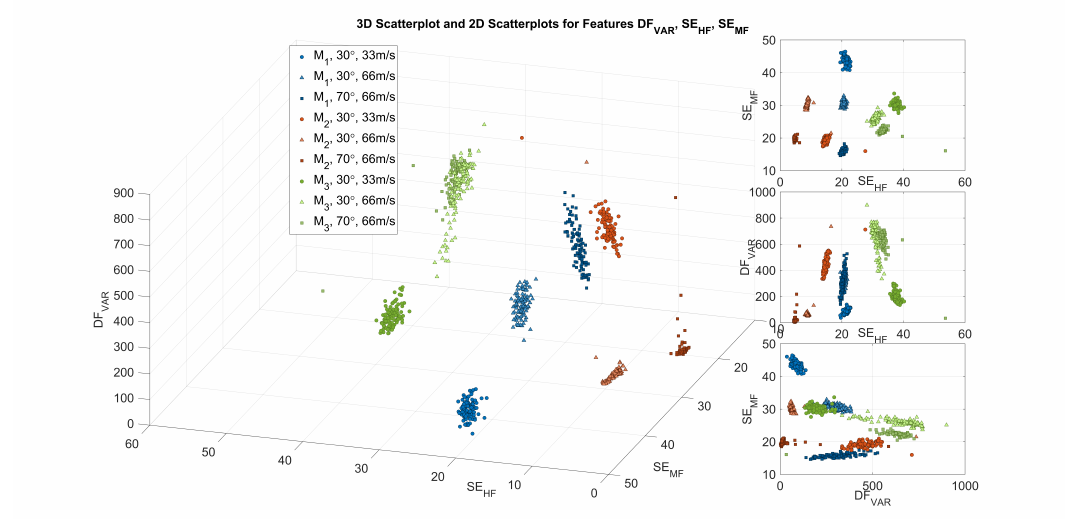
Figure 5. Exemplary 3D scatter plot along with 2D scatter plots of features DF VAR , SE HF , and SE MF for three palpation experiments per material M 1 − 3